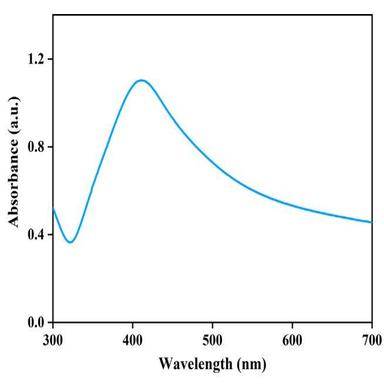
UV–Vis spectrum of Ag NPs.